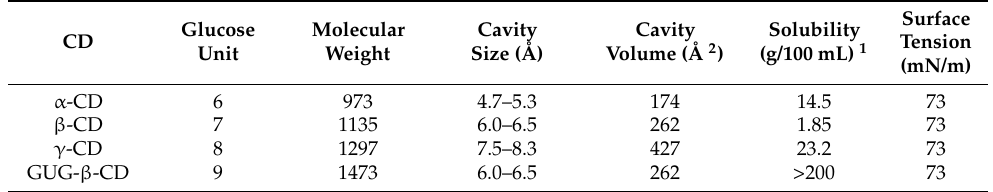
Figure 1. Chemical structure of α -CD, β -CD, γ -CD and glucuronylglucosyl- β -cyclodextrin (GUG- β -CD). Table 1. Structure and properties of parent cyclodextrins (CD) and glucuronylglucosyl- β -cyclodextrin (GUG- β -CD), based on References [10,17,18].